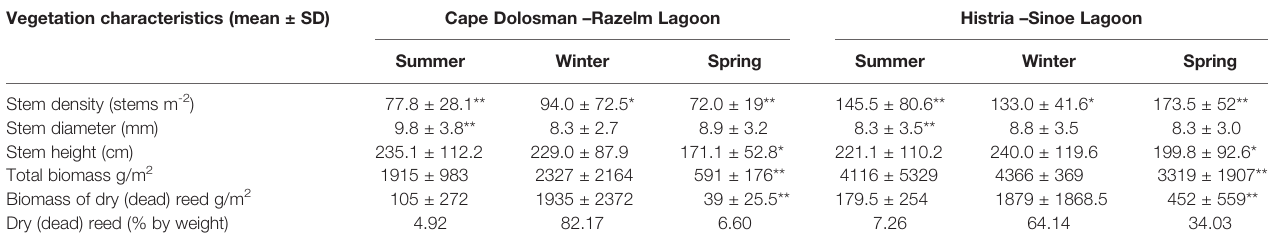
TABLE 1 | Vegetation characteristics at the two studied sites [**indicates difference at p < 0.05 signi fi cance level; *indicates difference at p < 0.10 signi fi cance level (two-tailed t-test) between the sites within the given season]. Vegetation characteristics (mean ±